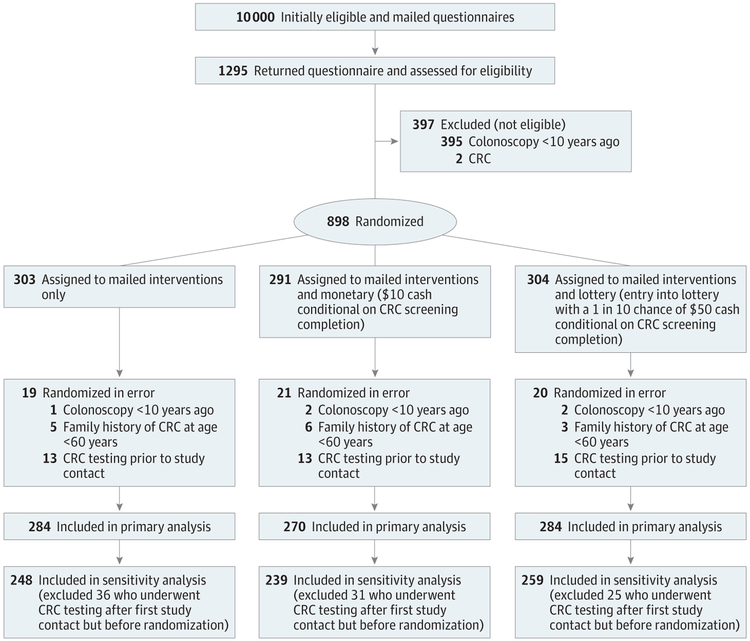
CONSORT Study Flow DiagramCRC indicates colorectal cancer.